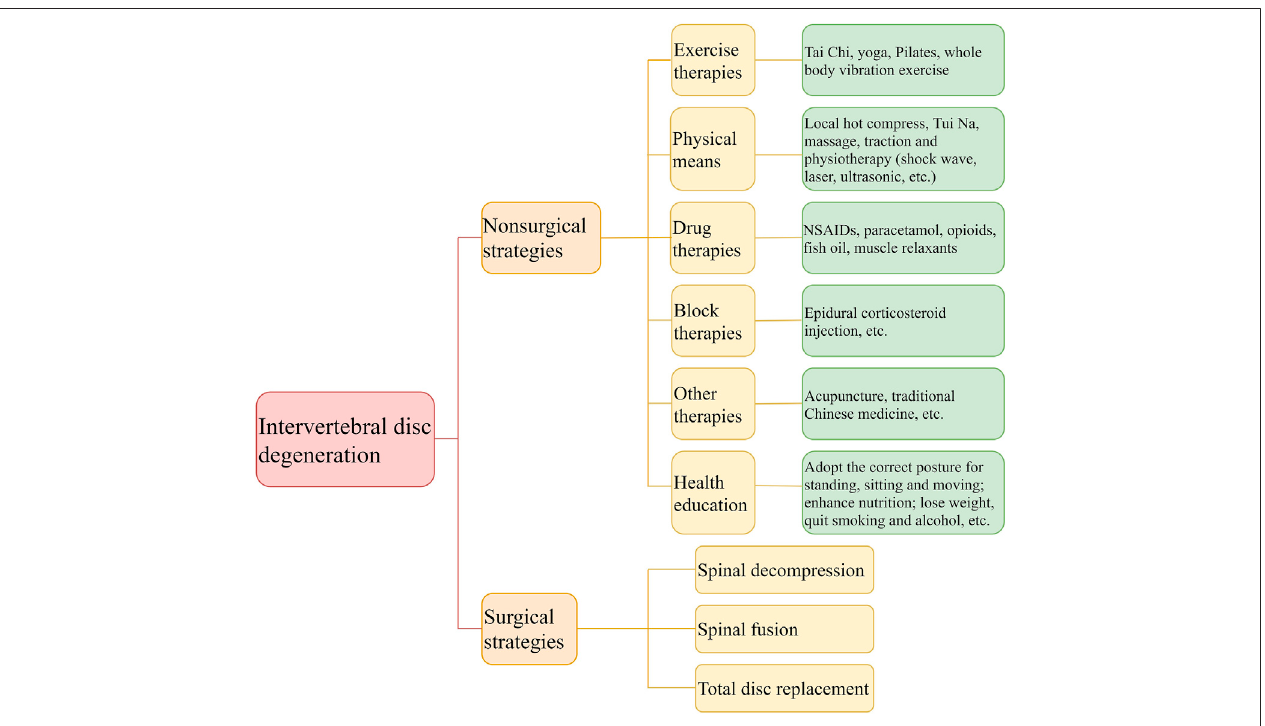
FIGURE 3 | Nonsurgical and surgical strategies for